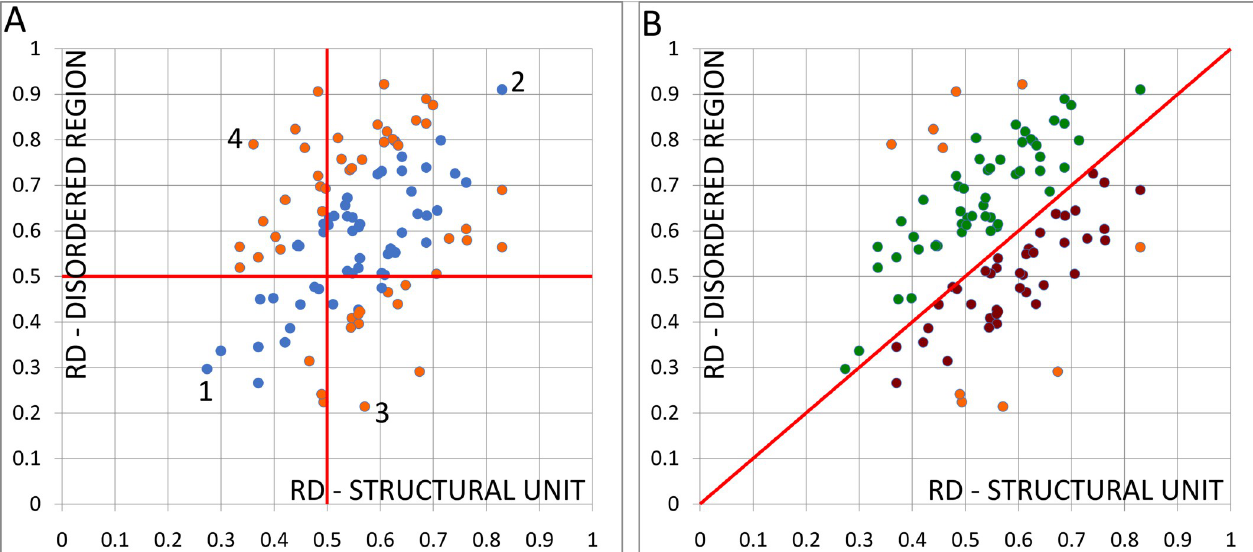
Fig 1. The scatterplots of the values of parameter RD for IDR and its structural unit (chain/domain) for the whole set of IDPs from S1 Table in S1 Appendix (detailed description–see text). A—(blue points “represent” the correlation coefficient 0.8). B–two subsets: The upper (green points) and the lower (red points) obtained by considering the location of points with respect to line RD IDR = RD SU . The orange points in A and B correspond to the outstanding points.